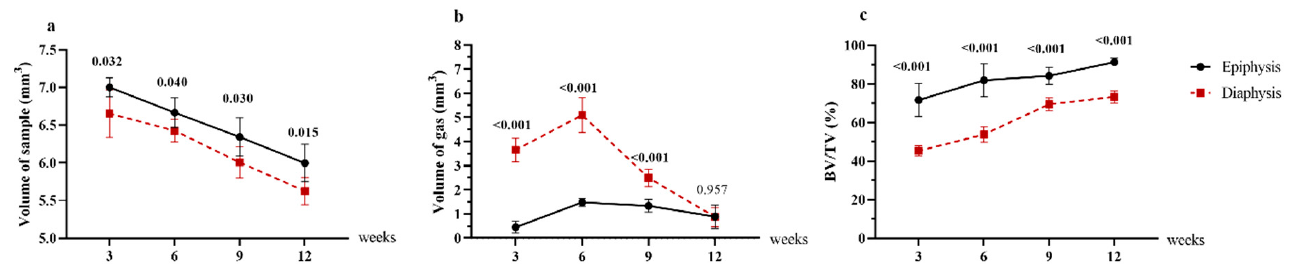
Figure 4. Quantitative analysis of micro-computed tomography. ( a ) The volume of the Mg rod, ( b ) gas pocket, ( c ), and bone volume fraction (BV/TV) around the implant, in the epiphysis (n = 6) and diaphysis (n = 6) groups at 3, 6, 9 and 12 weeks. Values are presented as the mean and standard deviation. Comparisons between two groups were evaluated using Student’s t -test, and p values are indicated at every time point. BV: new bone volume, TV: total tissue volume.